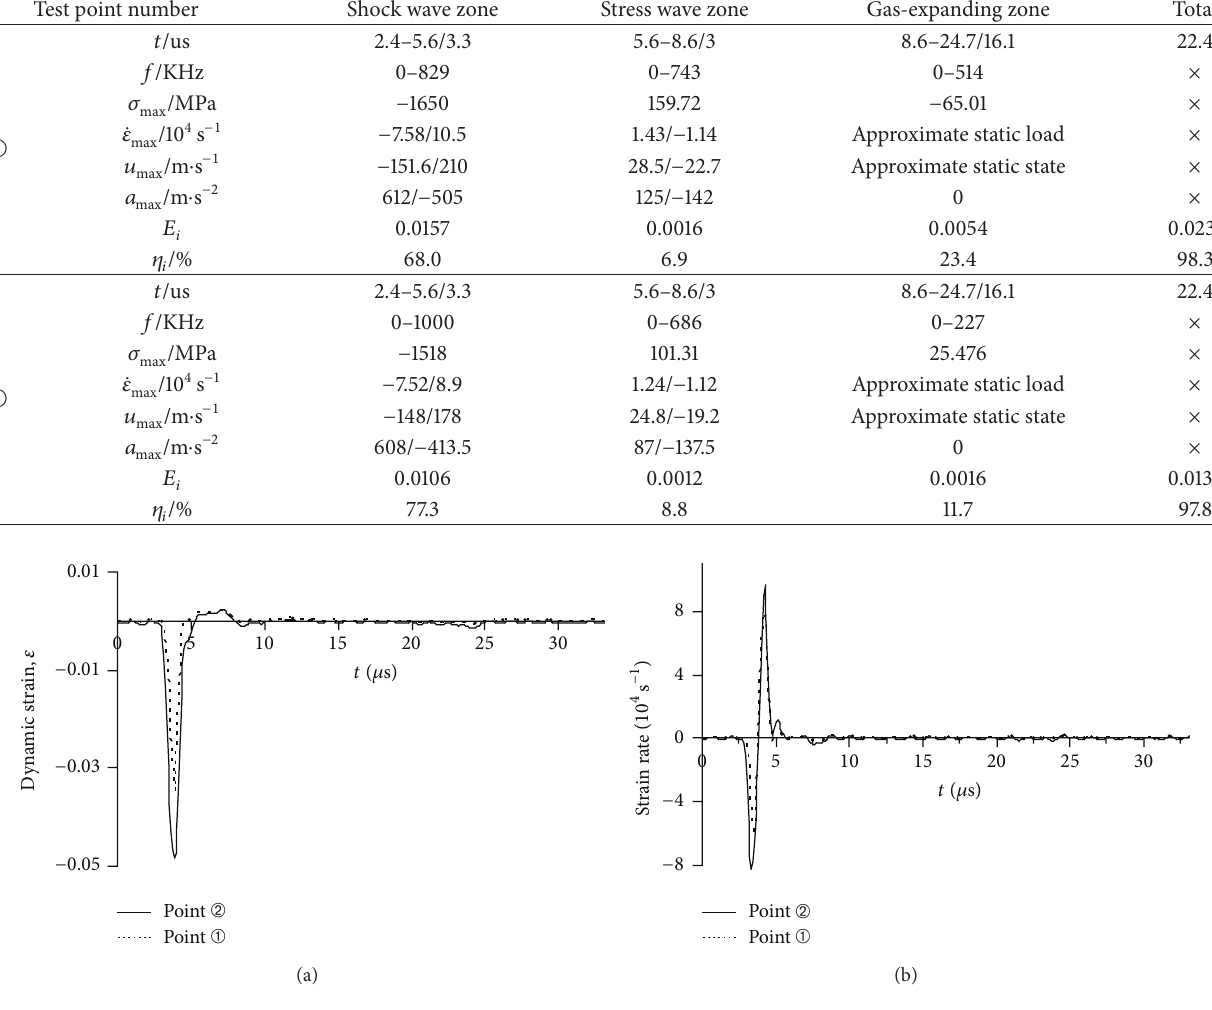
Figure 5: Measured curve of contacting blasting waveform.